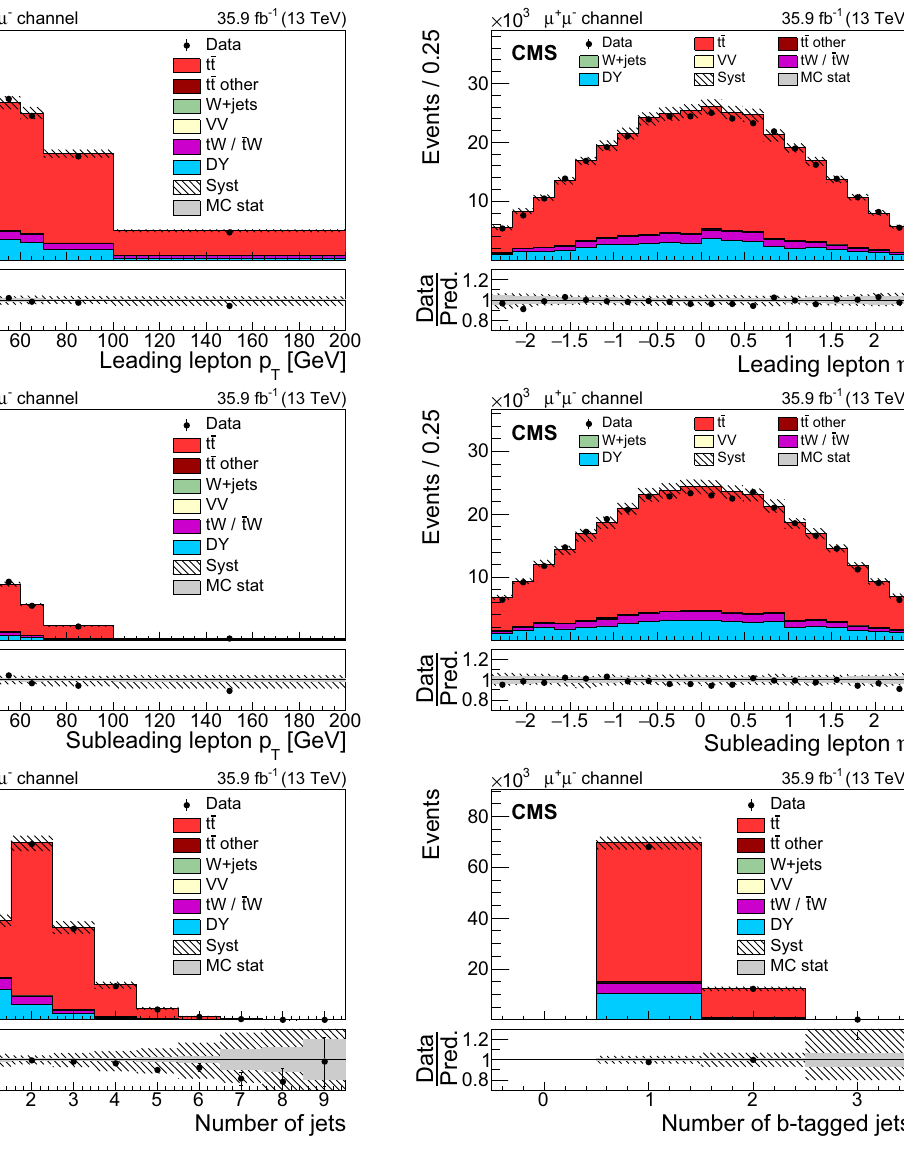
Fig. 2 The same distributions as in Fig. 1, but for the μ + μ − channel